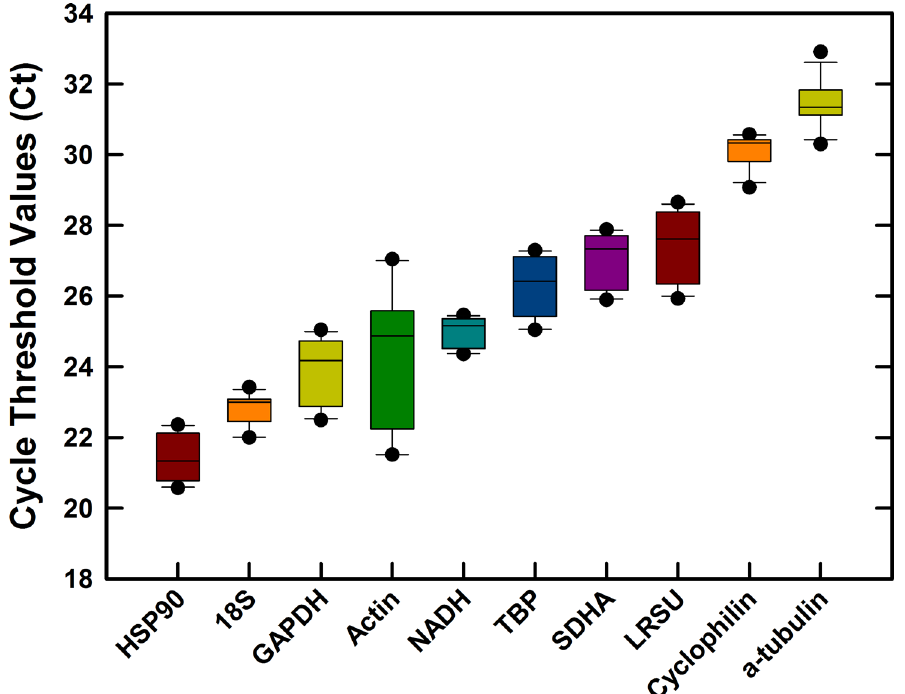
Fig 1. Stabilities of cycle threshold (Cq) values of ten candidate reference genes in Varroa destructor . The box plot with medians indicates the 25th and 75 th percentiles and the whiskers (error bars) indicate the 10 th and 90 th percentiles. Black dots represent outliers. Data for each gene from 3 replicates of each grouping (brood, phoretic, Low Virus and High Virus), each sample contained 8